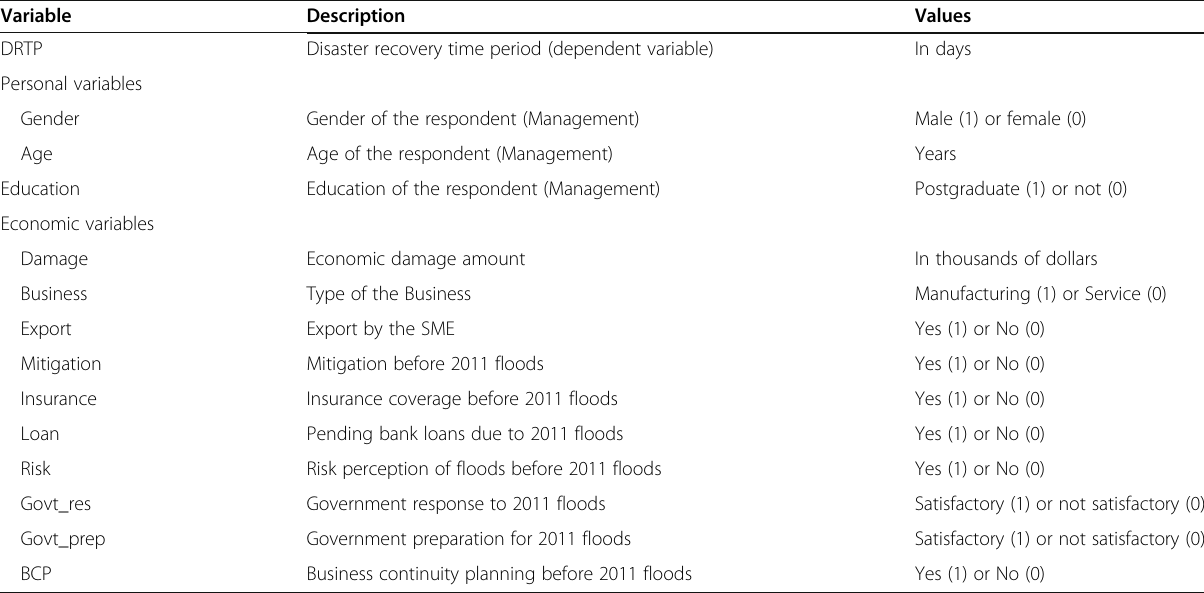
Table 1 Selected variables for analysing speed of disaster recovery Variable